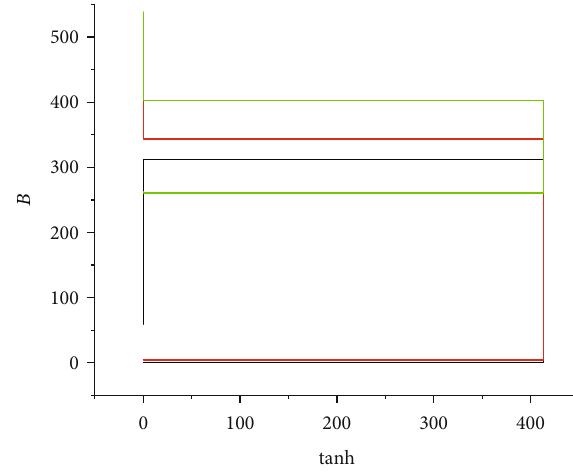
Figure 3: The coordinate diagram of tanh